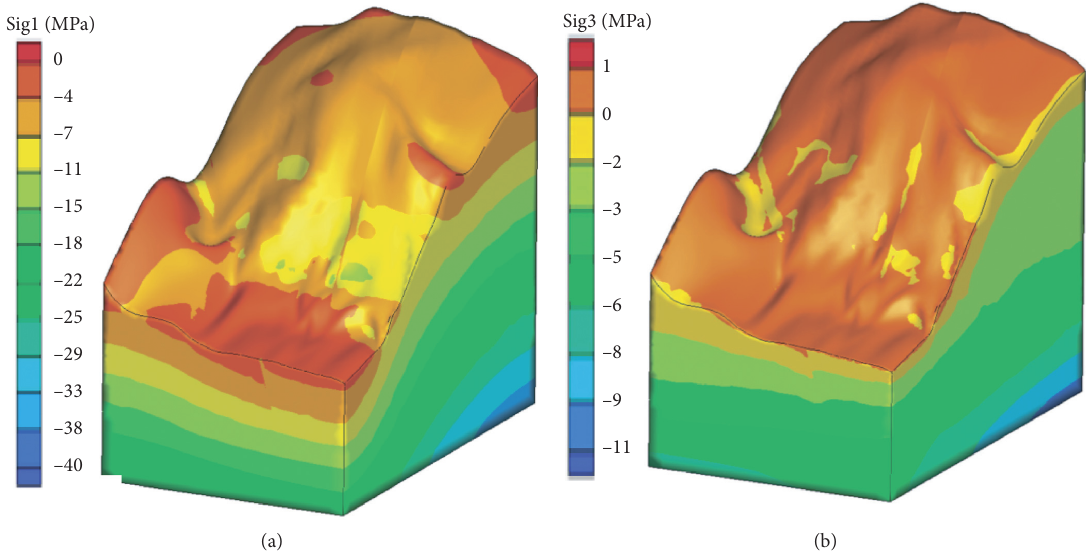
Figure 8: Cloud diagram of (a) maximum principal stress and (b) minimum principal stress of slope in natural state.